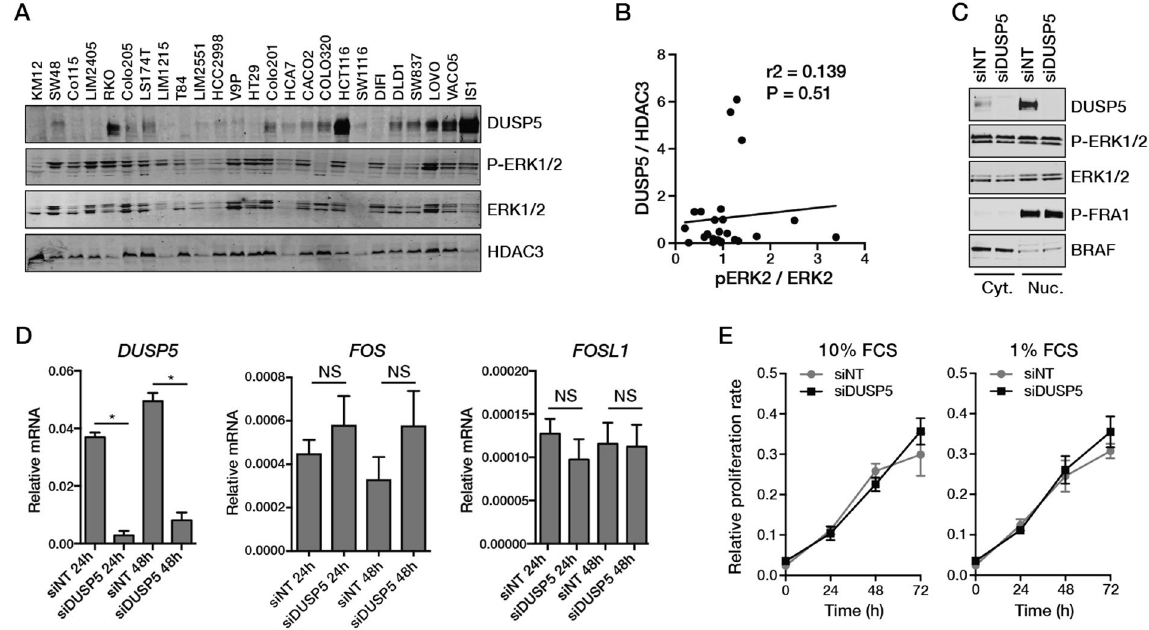
Figure 4. DUSP5 regulation of basal ERK signaling in CRC cells. ( A ) Relationship between DUSP5 expression and levels of phosphorylated and total ERK1/2 in nuclear extracts of CRC cell lines. HDAC3 was used as loading control. ( B ) Analysis of the correlation between DUSP5 expression normalized to HDAC3 and the p-ERK2/ERK2 ratio following densitometric analysis of the data shown in ( A ). ( C ) Effect of DUSP5 knockdown in RKO cells on cytoplasmic and nuclear levels of phosphorylated and total ERK1/2, and ERK-mediated phosphorylation of the transcription factor FRA1 ( FOSL1 ). BRAF was used as cytoplasmic marker. ( D ) Effect of DUSP5 knockdown on expression of the ERK-regulated genes FOSL1 and FOS in RKO cells. ( E ) Effect of DUSP5 knockdown on proliferation of RKO cells grown under normal (10% FCS) or low (1% FCS) serum conditions. * P < 0.05.